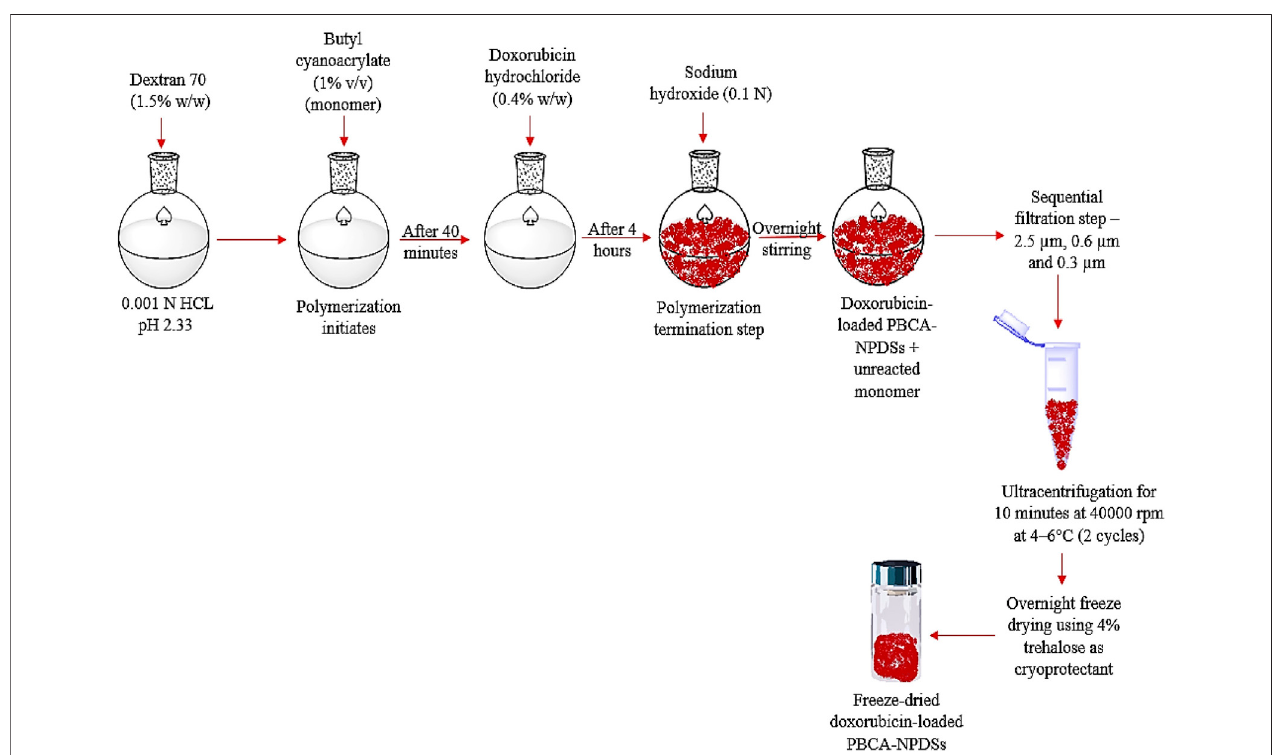
FIGURE 1 | Schematic representation of the steps involved in fabrication of doxorubicin-loaded PBCA-NPs.